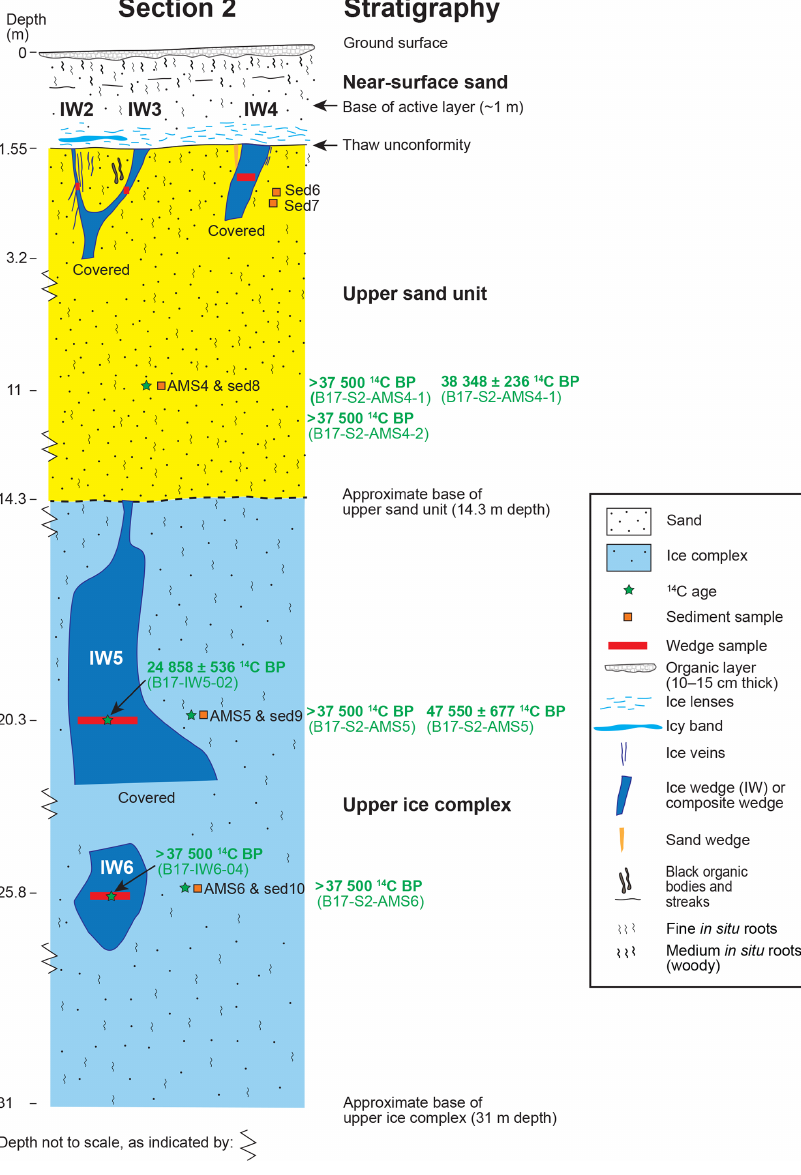
2010b). Results are reported as F 14 C (Reimer et al.,